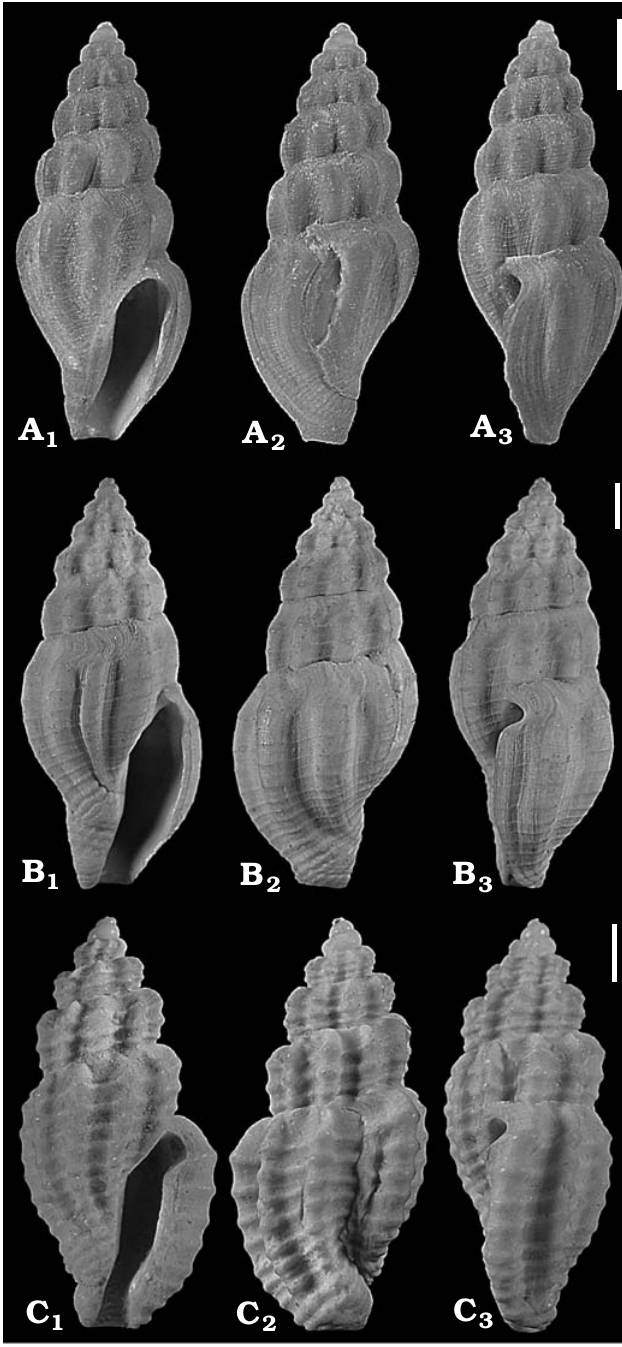
Fig. 6. Photomicrographs of holotype shell of new conoidean gastropods from early Serravallian of western Ukraine, Varovtsi (A, B) and Horodok (C). A . Bela varovtsiana sp. nov., MGGC-24516. B . Bela ? robusta sp.